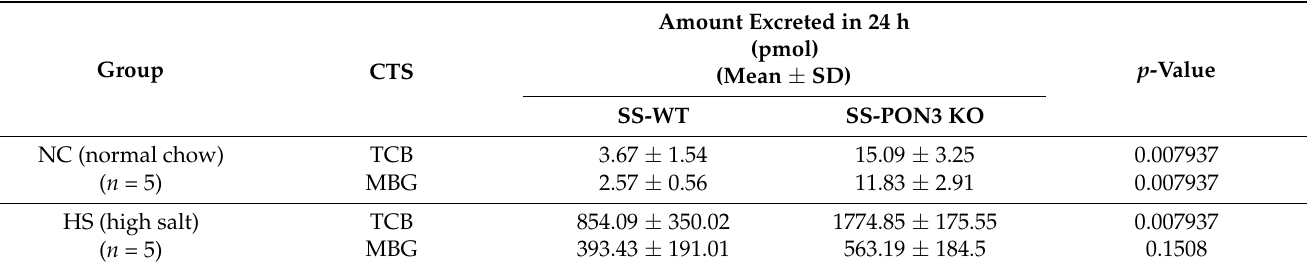
Table 2. The comparison of 24 h concentration levels of TCB and MBG in rat urine based on the presence and absence of PON3 (calculated by Mann–Whitney U test, n =